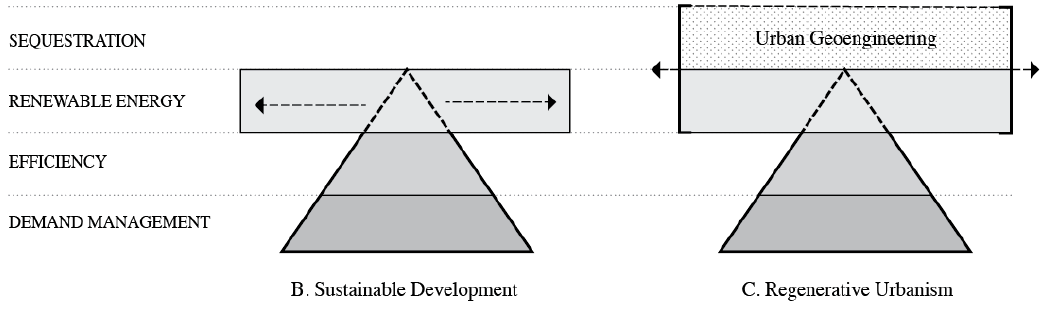
Figure 4. Conceptual diagram of the carbon reduction elements of Sustainable Development ( B ) and Regenerative Urbanism ( C ).